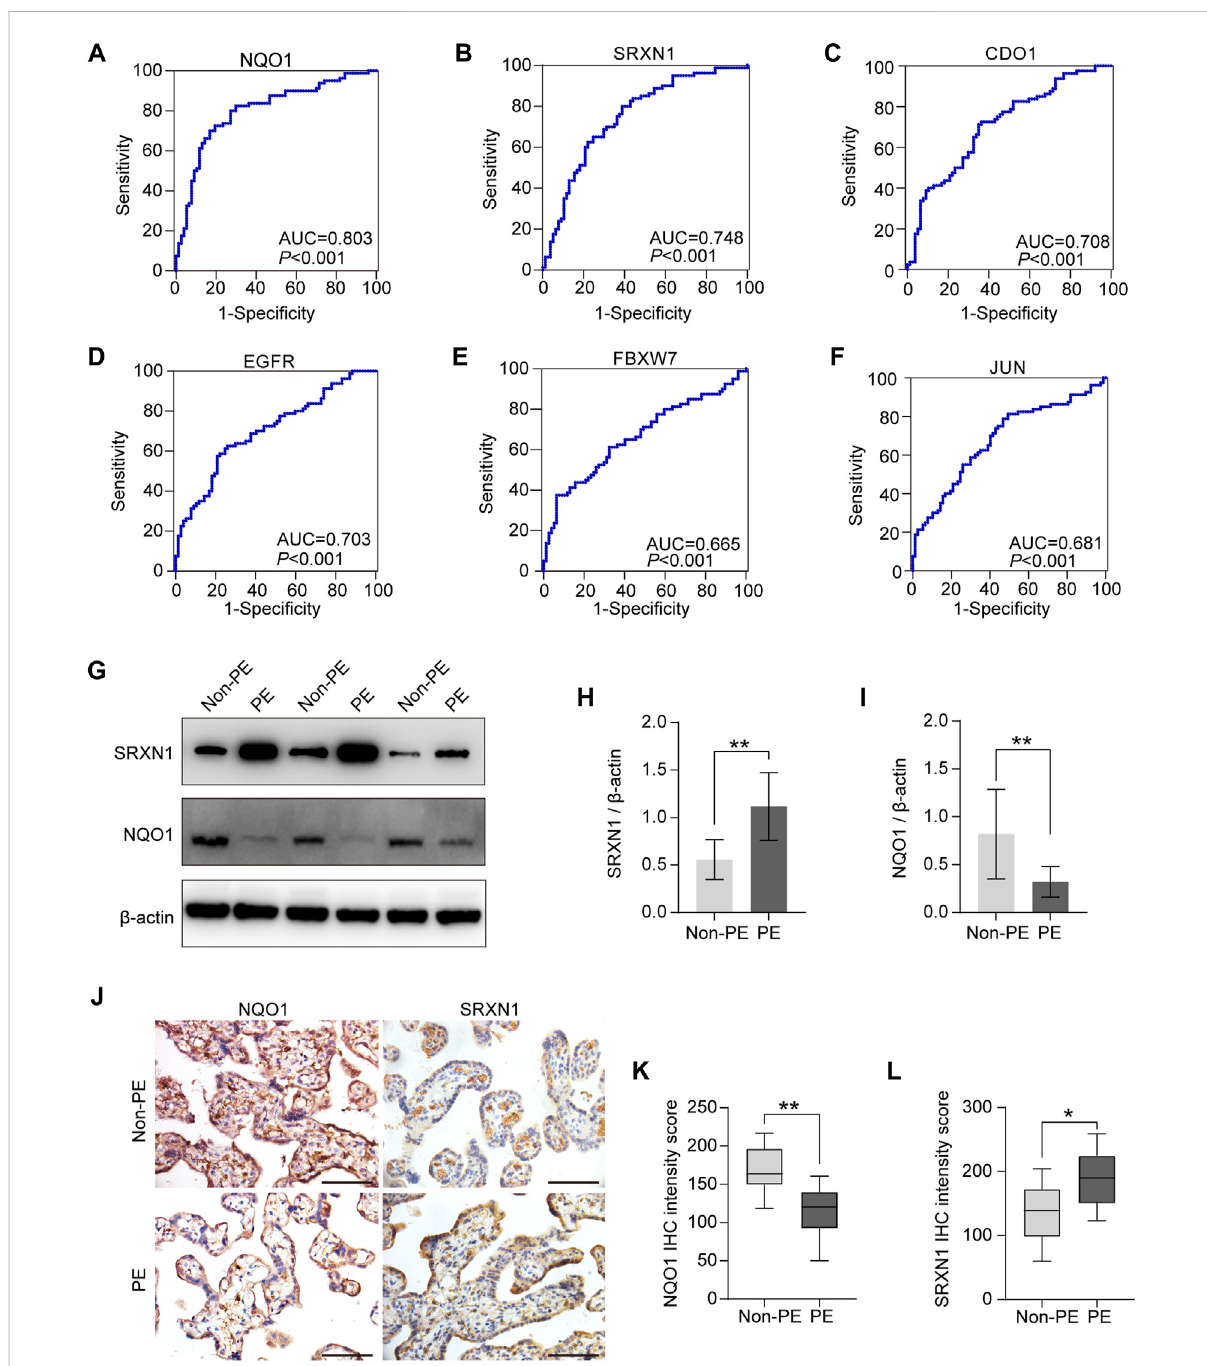
FIGURE 6 Diagnosticaccuracyanalysisandexperimentalveri fi cationofsixhubgenes. (A – F) ROCcurveswereplottedtoexaminethediagnosticpotential and discriminatory accuracy of NQO1 (A) , SRXN1 (B) , CDO1 (C) , EGFR (D) , FBXW7 (E) , and JUN. (F – I) Western blot analysis of NQO1 and SRXN1 protein expression (G) , and gray-scale analysis of Western blot analysis results (H – J) . Representative images of immunohistochemical staining for NQO1 and SRXN1 in human placenta from normal pregnancy and preeclampsia. (K,L) Statistical analysis of immunohistochemistry results in non-PE placenta tissues ( n = 15) and PE placenta tissues ( n = 15). IHC means immunohistochemistry. * p < 0.05; ** p < 0.01; *** p < 0.001. Scale bars = 50 μ m in (J)